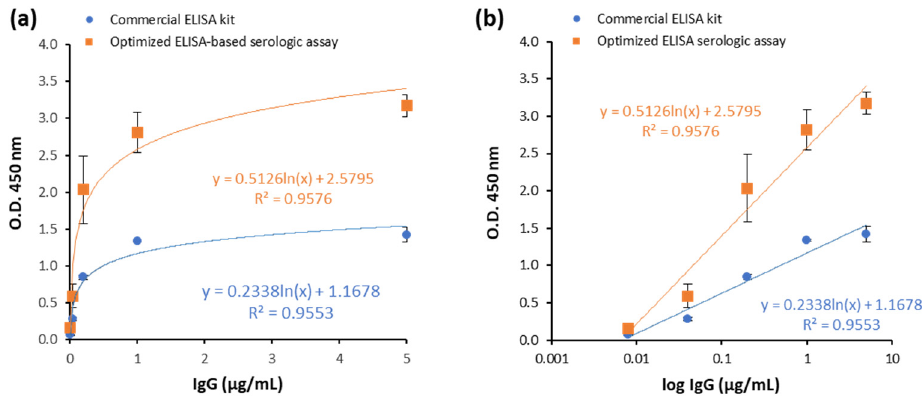
Figure 3. Comparison of the calibration curves of the commercial ELISA kit and the optimized ELISA-based serological assay. ( a ) Hyperbolic representation. ( b ) Linear representation using a logarithmic scale in the X axis. Datapoints of the commercial kit are indicated as orange squares, while those of the optimized assay are indicated with blue circles. Table 2. Determination of proper human serum dilution, performed in the optimized ELISA- based serology assay. Optical density values are shown for eight randomly chosen samples assayed in duplicate. Different sample dilutions were measured with the optimized serology assay in comparison with the commercial ELISA kit at the manufacturer’s recommended dilution. Results are the mean ±